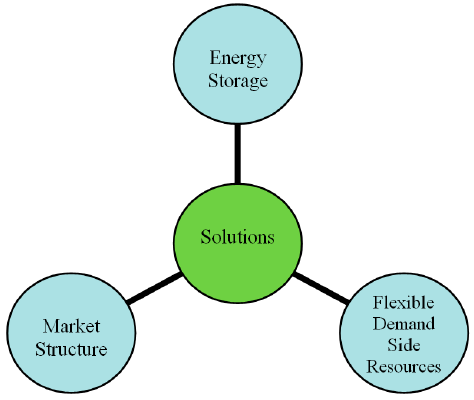
Figure 1. Solutions for power system operators to administer a more fl exible power grid.